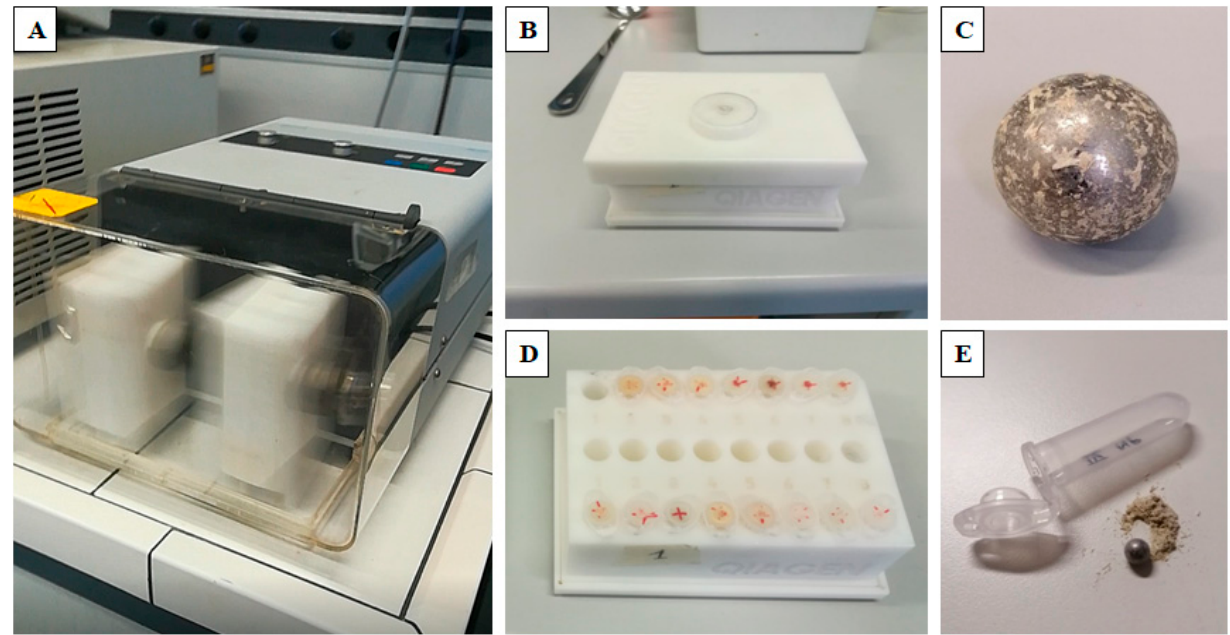
Figure 1. Equipment for milling tree-ring samples with standard and new protocol. Panel ( A ) shows the Mixer mill MM 400 (Retsch GmbH, Haan, Germany) used for milling tree rings in both protocols. Panels ( B , D ) show the plate used for multiple milling of tree-ring samples (up to 12 samples in each plate). Panel ( C ) shows an example of loss of wood material with the standard protocol, in particular, the milled material attached on the grinding ball which is particularly hard to retrieve. Panel ( E ) shows the small steel bead used and the wood powder obtained after milling.